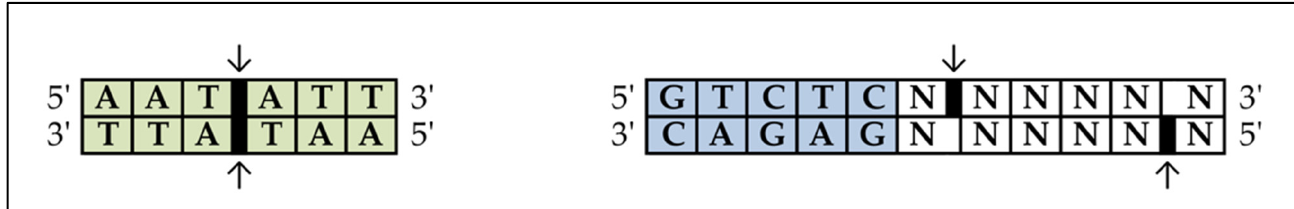
Figure 1. The sequences of recognition and cleavage sites of SspI and BsmAI.